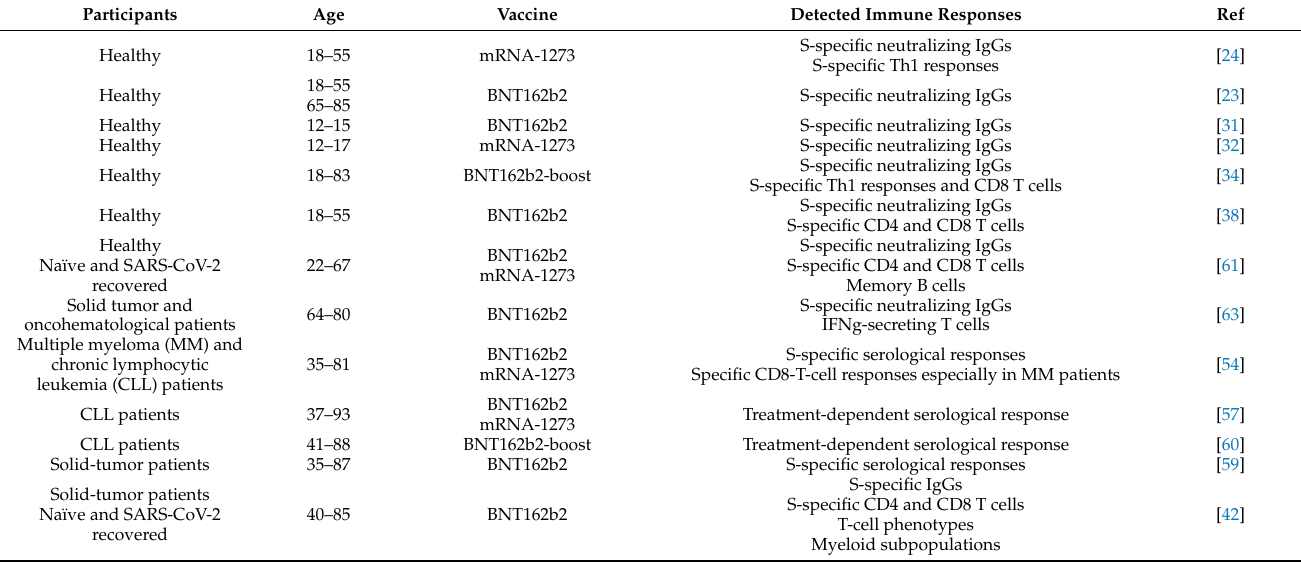
Table 1. Detectable immune responses in different studies performed in either healthy or oncologic participants after mRNA